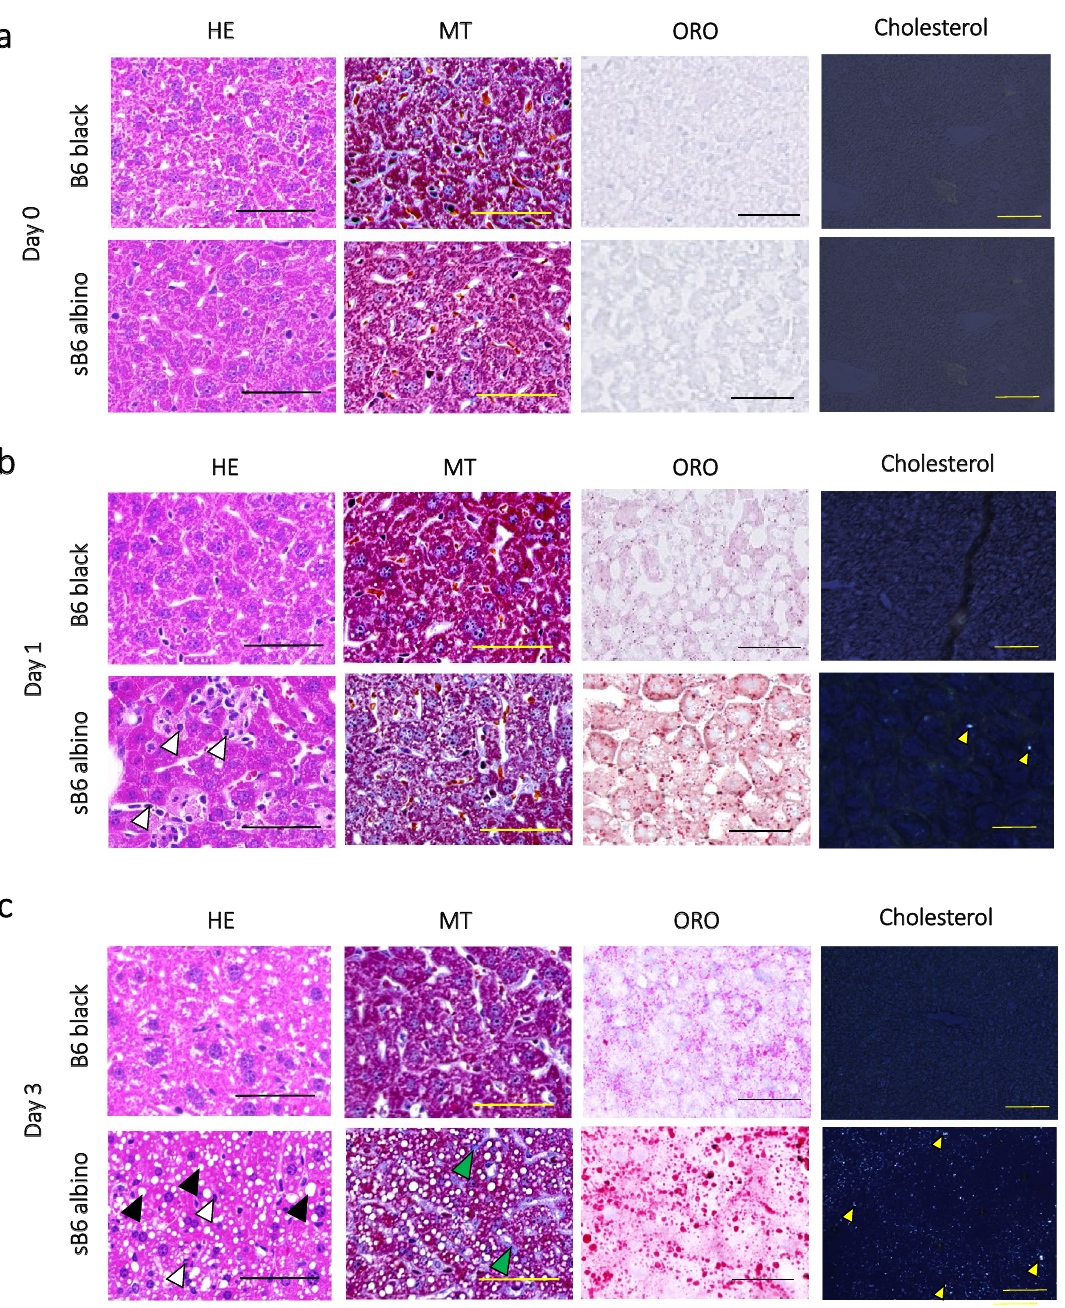
Figure 2. Rapid onset of NASH phenotype in sB6 albino mice upon HCD induction. ( a ) Representative microscopic images of liver tissues before HCD ( a ), 1-day ( b ), and 3-days ( c ) after HCD feeding. Liver sections were stained with HE, MT, and ORO. Samples were analyzed under polarized light to observe cholesterol crystal accumulation. (Scale bar = 50 μm). Black arrowhead: lipid droplet, white arrowhead: immune cell, green arrowhead: fibrotic region, yellow arrowhead: cholesterol crystal. Data are from one representative experiment of at least two independent